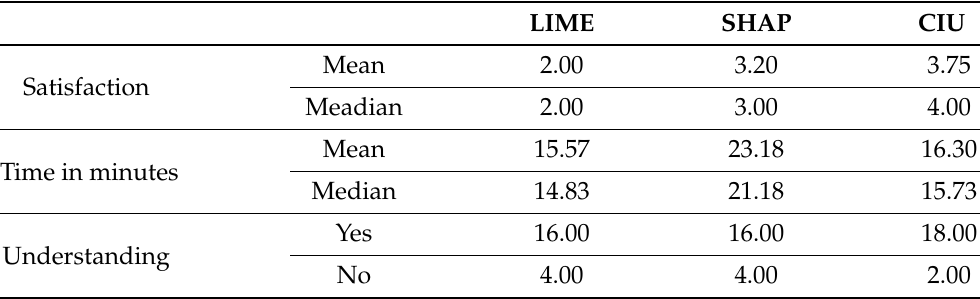
Table 12. Mean and median values of satisfaction, understanding and time